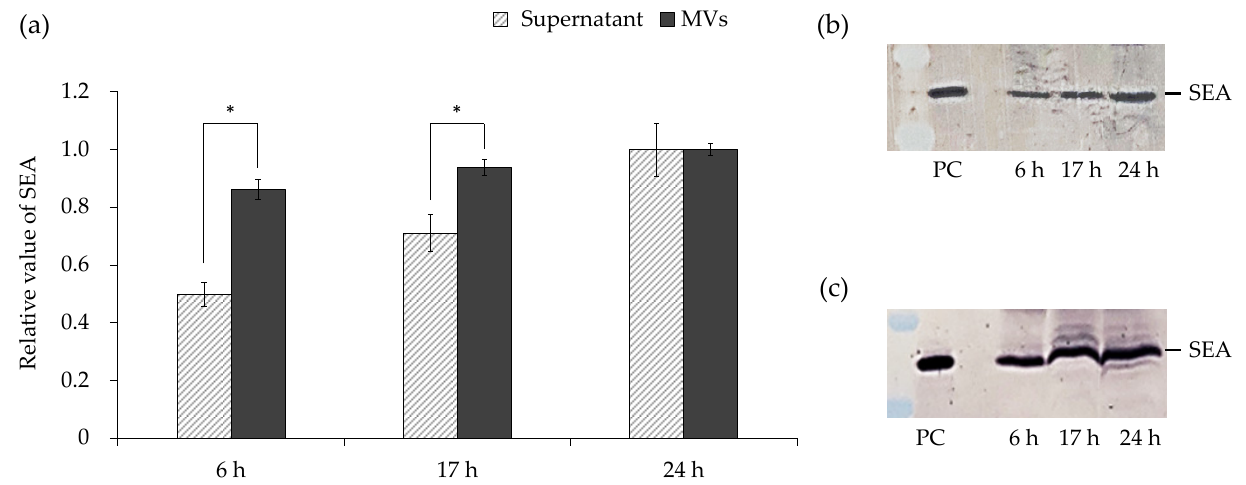
Figure 5. Comparison of the amount of SEA in the culture supernatant and membrane vesicles (MVs) derived from Staphylococcus aureus . ( a ) The relative value of SEA content in the culture supernatant and MVs. ( b ) The culture supernatant after different incubation periods (6, 17, and 24 h) and ( c ) corresponding MVs were analyzed by SDS-PAGE and visualized by Western blotting analysis. PC: positive control purified SEA. * represents p < 0.05 compared to 24 h. Values represent the mean ± SD of three independent experiments.